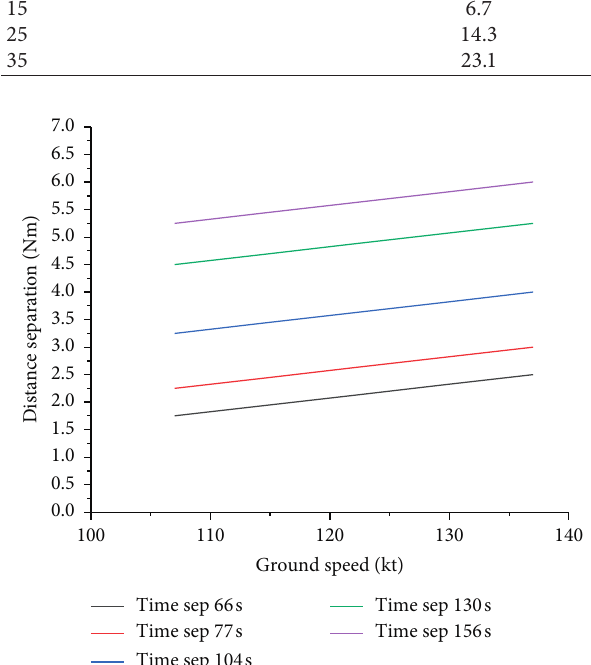
Figure 5: The same time separation reduces the longitudinal distance separation. With the decrease in ground speed, the dis- tance separation becomes smaller at the same time